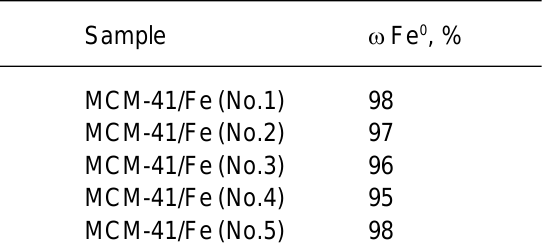
Table 3. Iron content in the samples (XRD data).